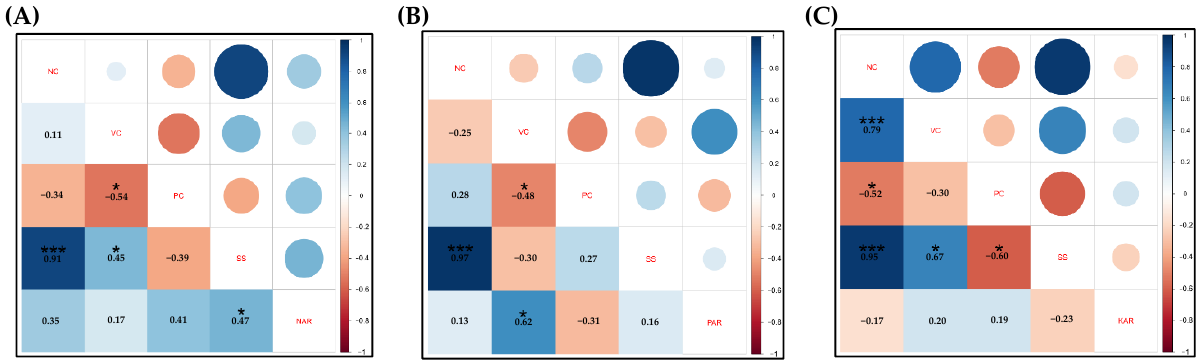
Figure 2. Correlation coefficient among N ( A ), P ( B ), and K ( C ) application rates and the four quality traits. NC, Nitrate concentration; VC, Vitamin C concentration; PC, Soluble protein concentration; SS, Soluble sugar concentration; NAR, N application rate; PAR, P application rate; and KAR, K application rate. * p < 0.05, ** p < 0.01, *** p < 0.001.